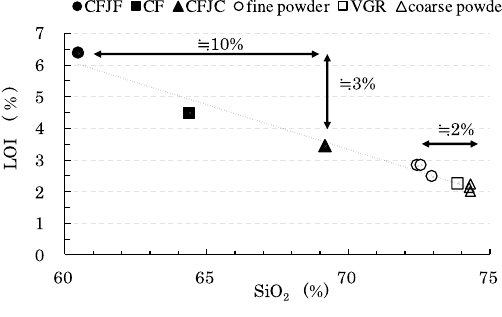
Fig. 8 Relation between SiO